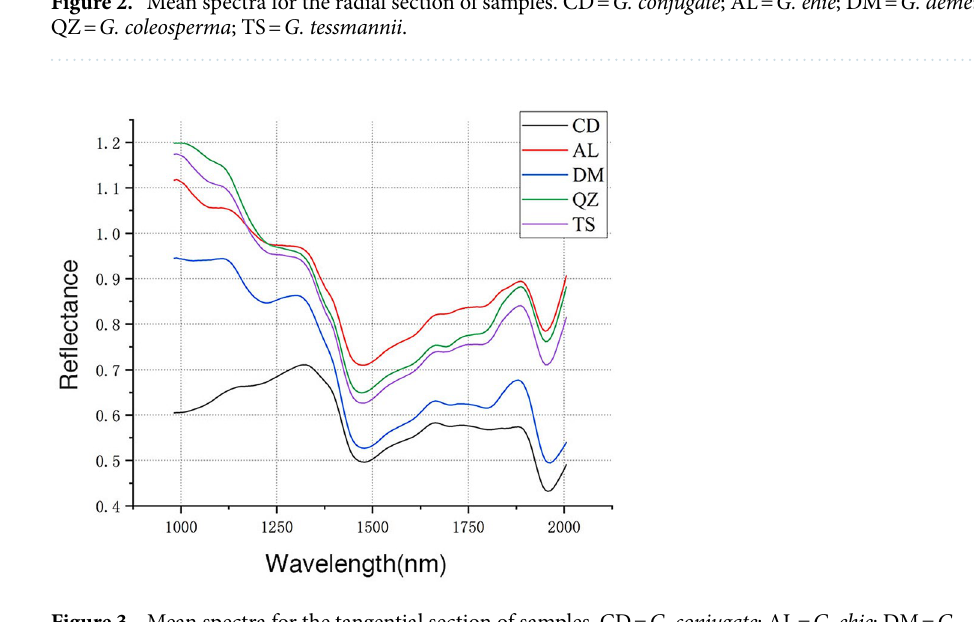
Figure 3. Mean spectra for the tangential section of samples. CD = G. conjugate ; AL = G. ehie ; DM = G. demeusei ; QZ = G. coleosperma ; TS = G. tessmannii